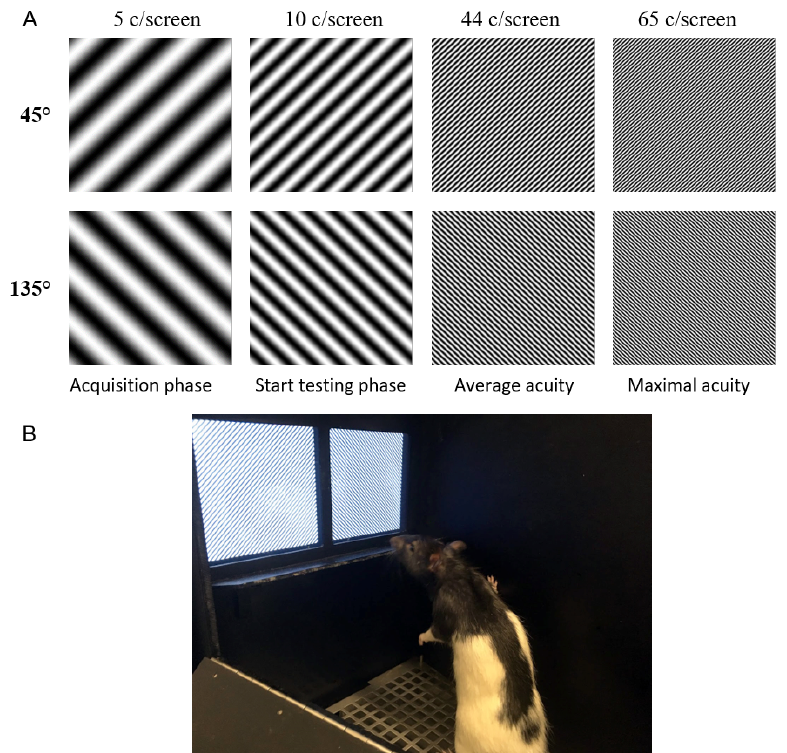
Figure 1. Example stimuli used in the testing phase. ( A ) Four example discrimination pairs shown to scale (30%). 5 and 10 c/screen are the lowest tested SFs, 44 c/screen is roughly the average acuity across animals (see results), and 65 c/screen is the highest acuity across animals. ( B ) Picture of rat in the touchscreen setup with 44 c/screen